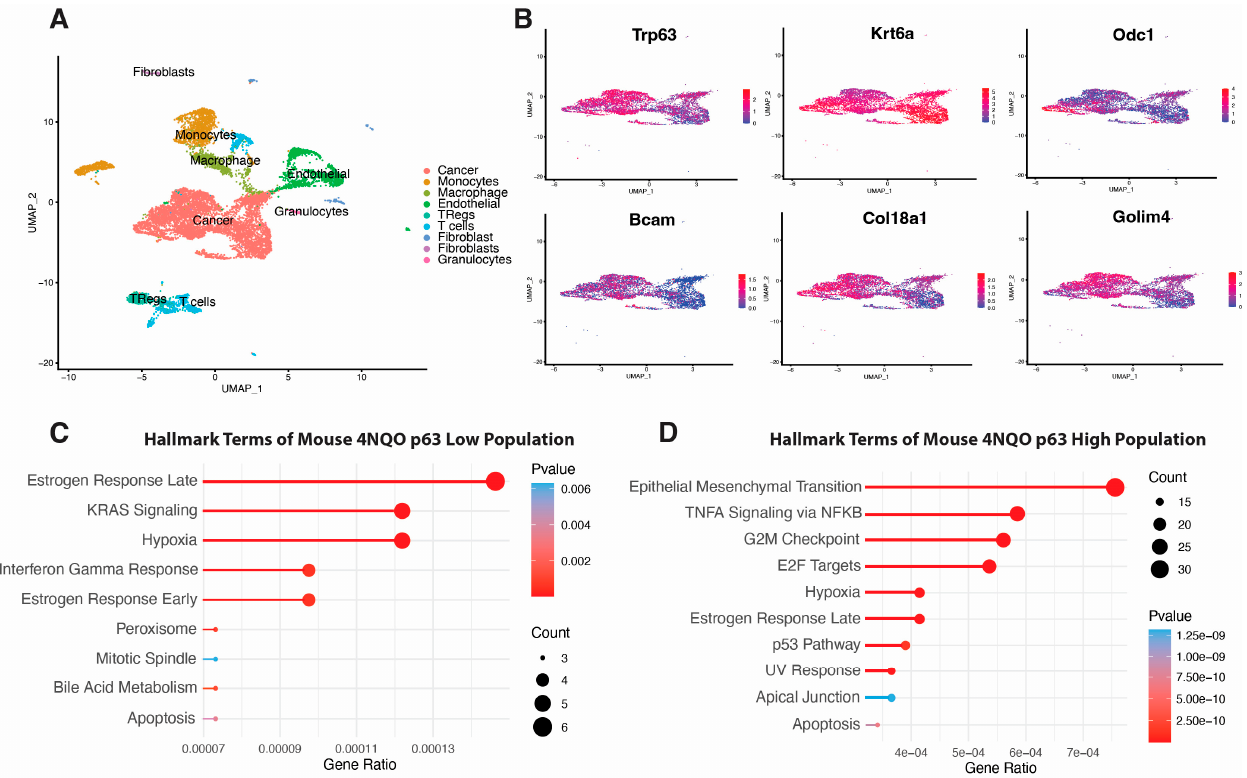
Figure 7. scRNA-seq analysis of 4NQO-induced mouse ESCC shows enrichment of our p63-based OSCC gene signature. ( A ) UMAP clustering of different cell types in mouse ESCC tumors. ( B ) UMAPs shows a zoomed-in cancer cell cluster highlighted from overall UMAP clustering. UMAP distribution of p63 expression across tumor cell clusters highlights p63 high and p63 low populations. DEG analysis of p63 high versus p63 low cells shows enrichment of several DEGs previously identified in the p63-based gene expression signature. UMAP projections display the expression of these factors across the tumor cell population. Enriched hallmark terms in DEGs enriched in p63 low ( C ) and p63 high ( D ) cells.